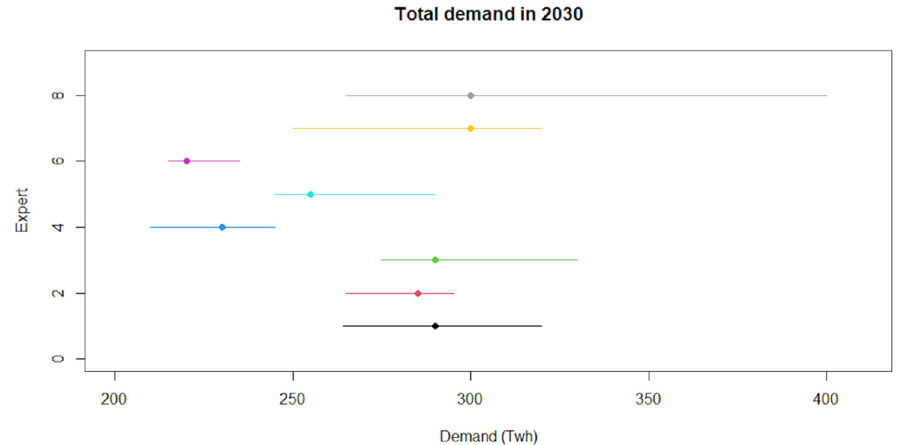
Figure 2. Interquartile range of total electricity demand in 2030 for the 8 participants. Each line represents the lower quartile to upper quartile, and dot is the median, of the elicited estimates for each participant.